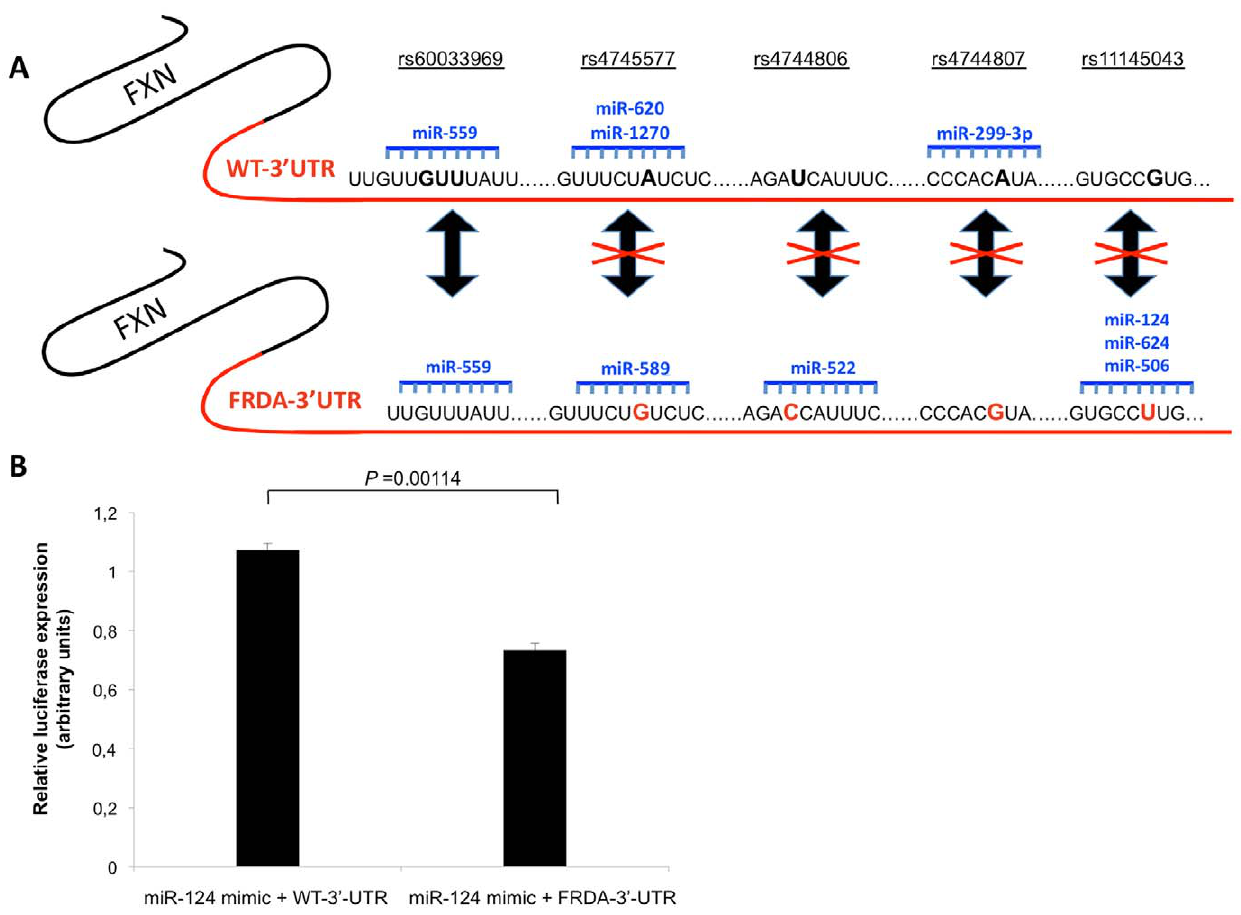
Figure 4. miRNAs targeting of FRDA-3 9 -UTR. A) Schematic representation of the nine miRNAs predicted to target FXN 3 9 -UTR dependengly on the haplotype: WT-3 9 -UTR (upper panel) or FRDA-3 9 -UTR (lower panel). The SNPs genotyped in the frataxin 3 9 -UTR are indicated in bold letters. Double arrows indicate whether the SNP is targeted by the same miRNA. Crossed double arrows indicates that the SNP is targeted by different miRNAs dependingly on the allele. B) Histograms illustrate the Renilla luciferase activity (normalized to firefly luciferase) following co-transfection of 10 nM miR-124 mimic with 150 ng of the indicated reporters into HEK 293 cells ( n =3). All results represent mean 6 SEM of three independent experiments, each in triplicate. * P , 0.05, Student-t